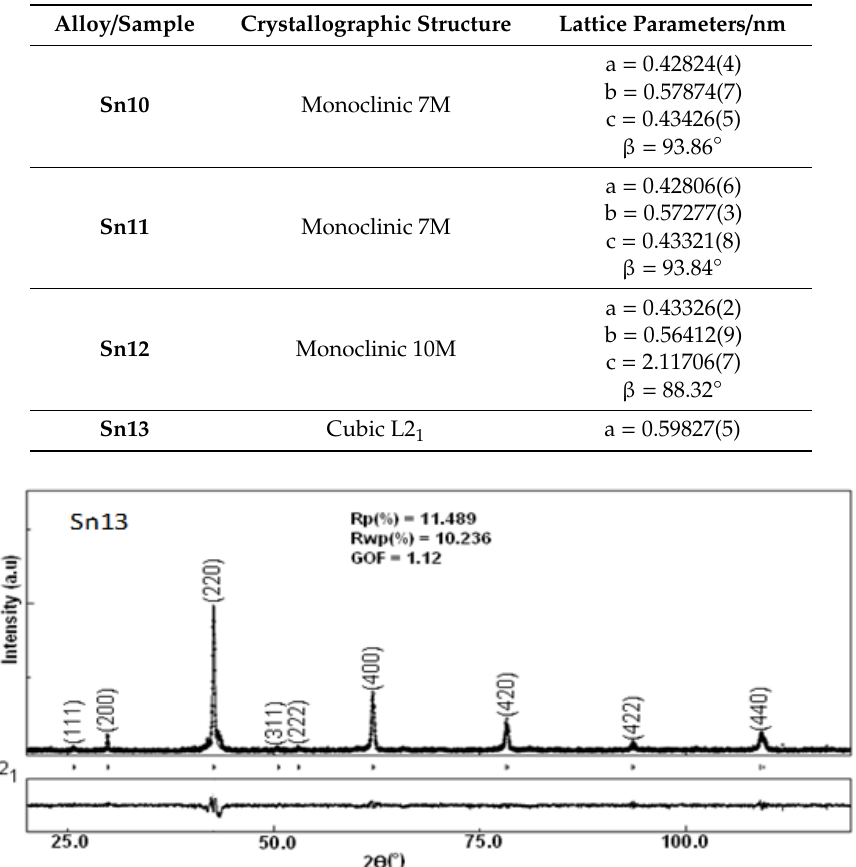
Figure 2. X-ray diffraction pattern (room temperature) for Ni 50 Mn 37 Sn 13 alloy. The crystallographic structure is identified as cubic L2 1 . Table 1. Crystallographic parameters of samples labeled as Sn10, Sn11, Sn12, and Sn13. Alloy/Sample